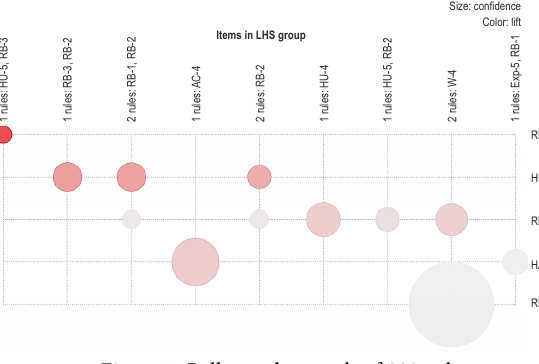
Figure 7. Balloon plot graph of 202 rules